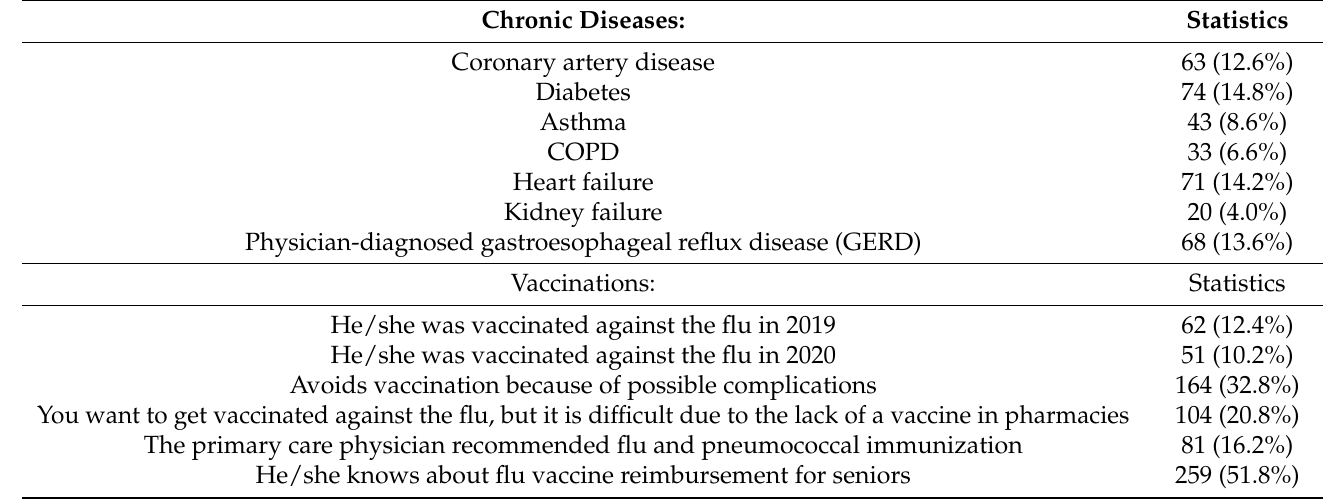
Table 2. Clinical characteristics of the studied